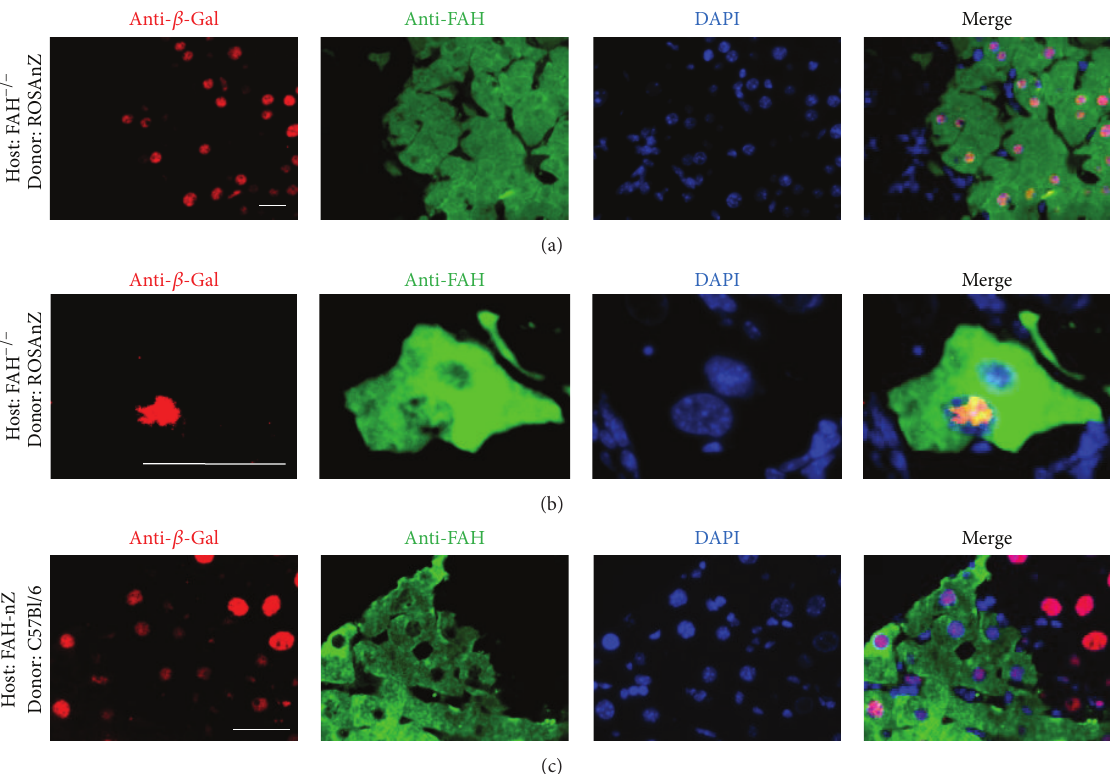
Figure 1: Cell fusion. Colocalization of 𝛽 -Gal (red) and Fah (green) expression in regenerating hepatic nodules (Group 1) (a). Donor-derived hepatocyteswithasingleFah + hepatocytecontainingtwonuclei,ofwhichonlyoneexpressed 𝛽 -Gal + ina 𝐹𝑎ℎ −/− mousethatreceivedROSAnZ BMCs (b). Hepatocytes expressing 𝛽 -Gal + in their nuclei, which were formed by host and donor-derived hepatocytes, expressed Fah + in their cytoplasm, which was derived from the donor, in the regenerating nodules of 𝐹𝑎ℎ −/− -ROSAnZ mice that received C57Bl/6J BMCs (Group